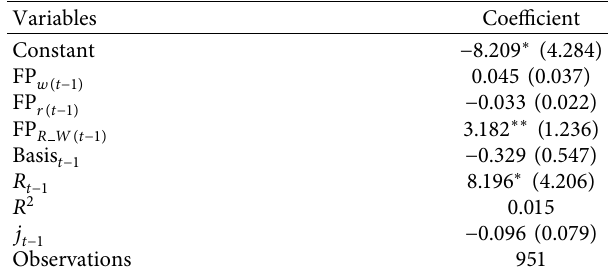
Table 3: Conventional model variables and coefficient estimation. Table 4: All possible fitted models along with log-likelihood